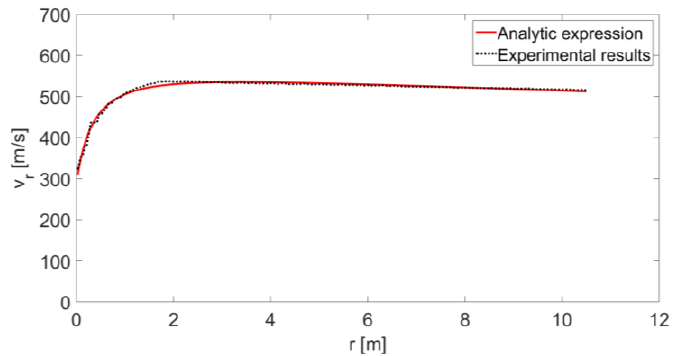
Figure 16. Instantaneous velocity of the small object as dependent on r .